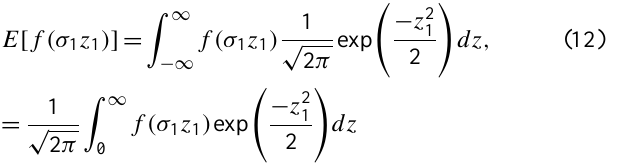
Fig. 3. Relationship between η (proportional change in temperature variance) and ∆ (difference in average respiration) for an exponen- tial function R = exp( T ) .